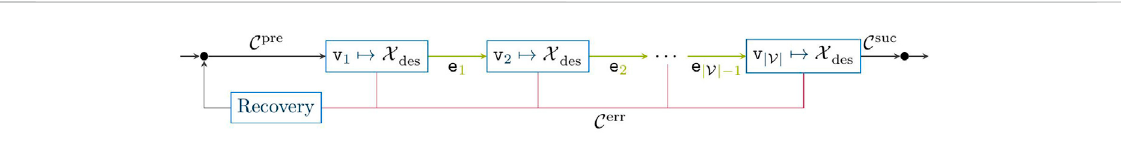
FIGURE 1 Schematic skill-formalism for manipulation tasks as presented in Johannsmeier et al. (2019). Each MP — i.e., node v i de fi nes the current set- valuesfortheunderlyingcontroller,e.g.,desiredwrenchorvelocity,aswellthecurrentmetaparametersthatde fi netheperformanceoftheskill,e.g., controller parameterization. Eventually, the Recovery node intends to steer the robot to the initial state whenever an error